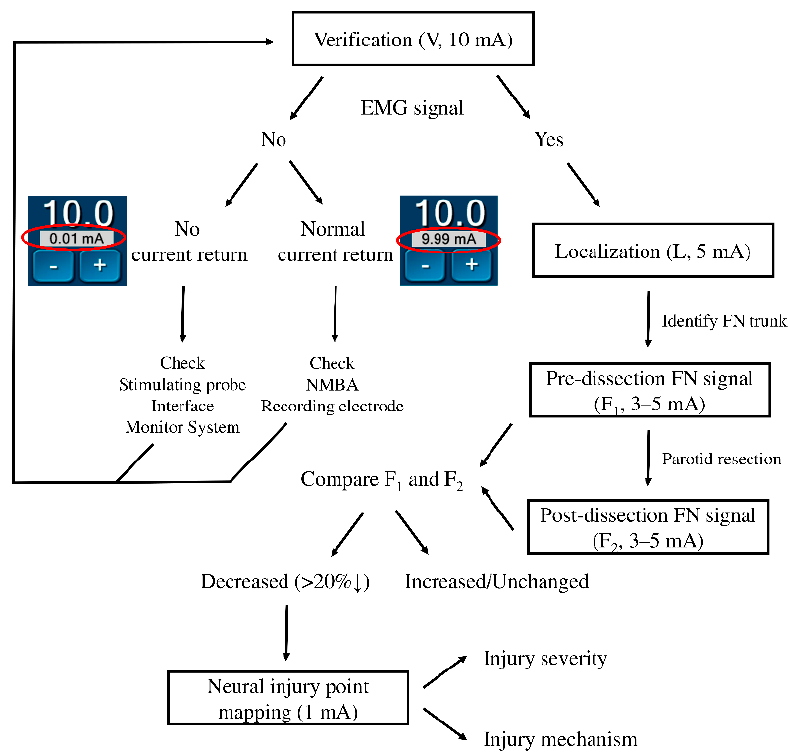
Figure 3. Flowchart of the facial nerve (FN) monitoring procedures and application of stimulus currents. The data in the red circle are the current return during verification with a 10 mA stimulus. EMG = electromyography, NMBA = neuromuscular blocking agents.